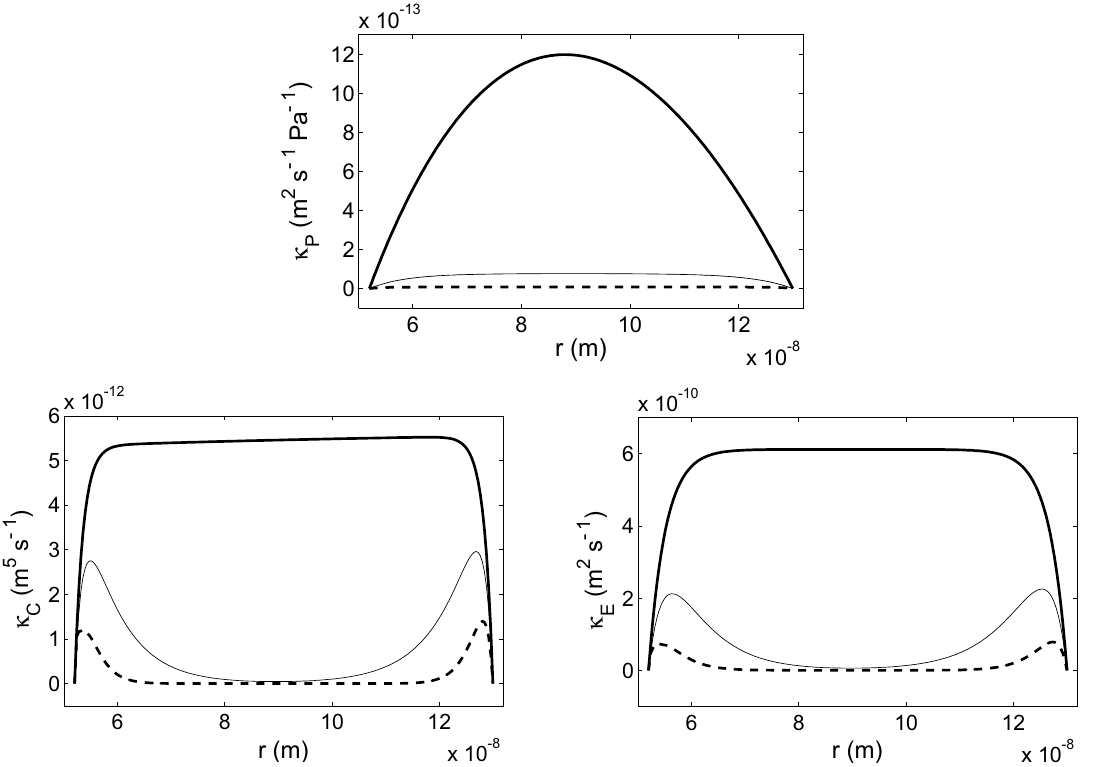
Fig. 2 – Profile of the local permeability parameters κ α , for α = P, C, E, at the pore’s scale considering Poiseuille effect (on the top), Osmotic effect (on the left), Electro-osmotic effect (on the right) for various values of the fibers permeability parameter K f expressed in m 2 : K f −→ ∞ (bold solid line), K f = 5 × 10 − 17 (thin solid line), K f = 5 × 10 − 18 (bold dashed